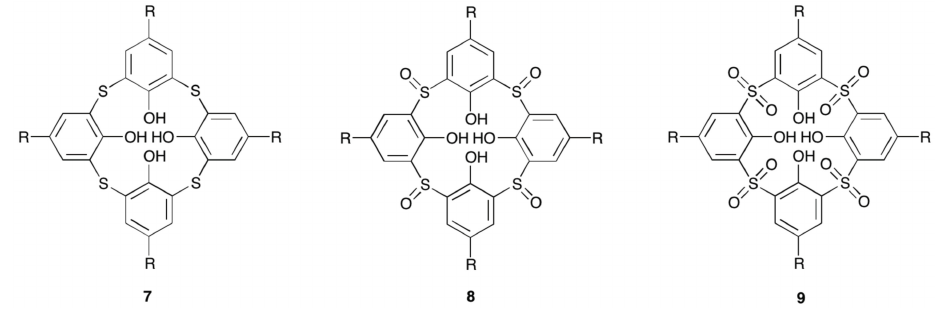
Figure 9. General structures of thiacalix[4]arene, 7 ; sulfinylcalix[4]arene, 8 ; and, sulfonylcalix[4]arene, 9 .